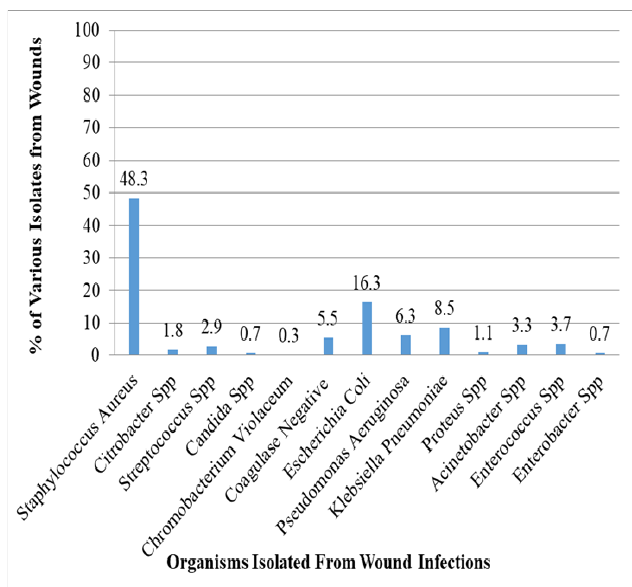
Fig. 1. Organisms isolated from wound